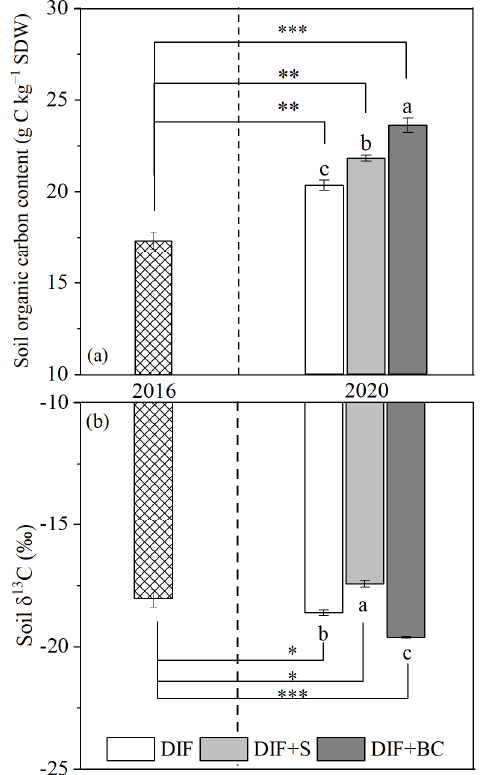
Figure 6. Observed changes in topsoil (0–30 cm) SOC contents ( a ) and soil organic matter δ 13 C values ( b ) for different treatments between January 2016 (start of the experiment) and February 2020. DIF: drip fertigation; DIF+S: drip fertigation with straw incorporation; DIF+BC: drip fertigation with biochar incorporation. Different lowercase letters indicate significant difference amongst three treatments at the end of experiment ( p < 0.05, n = 3). *, ** and *** mean significant difference between 2016 and 2020 ( p < 0.05, p < 0.01, p < 0.001, n = 3).